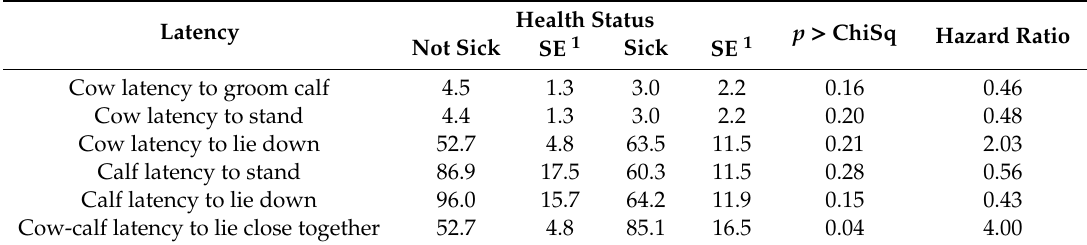
Table 2. Means and standard errors for the latency of ‘sick’ (clinical sign of illness and rectal temperature ≥ 39.1 ◦ C 9 within 24 h after calving) and ‘not sick’ (no clinical sign of illness and rectal temperature ≥ 39.1 ◦ C within 3 d after calving) cows and their calves to perform behaviours after the moment of